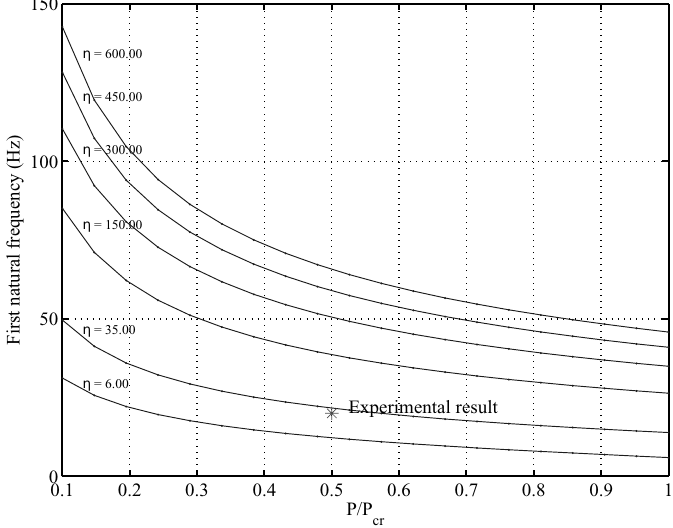
Fig. 11. Variation of the first natural frequency of the cantilever pile with respect to the axial load for different values of normalized soil stiffness. The experimental result ( f 1 = 20 Hz, θ c = P/P cr = 0 . 5 and η = 35 . 0 ) is shown by a ‘*’ in the diagram.